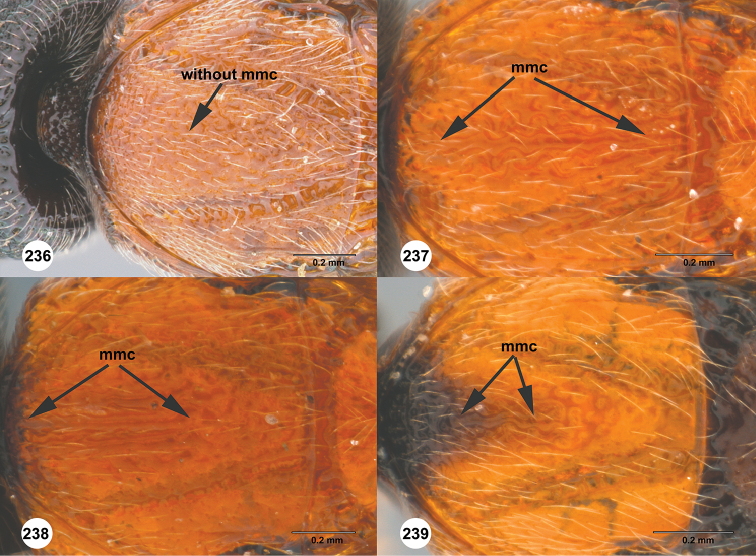
Mesoscutum, mmc: median mesoscutal carina 236Chromoteleiatricarinata Kieffer, male, holotype (CAS TYPE9759) 237Chromoteleiaconnectens Kieffer, female, holotype (CAS TYPE9618) 238Chromoteleialongitarsis Kieffer, male, holotype (CAS TYPE9682) 239Chromoteleiacurta sp. n., female, holotype (OSUC185626).